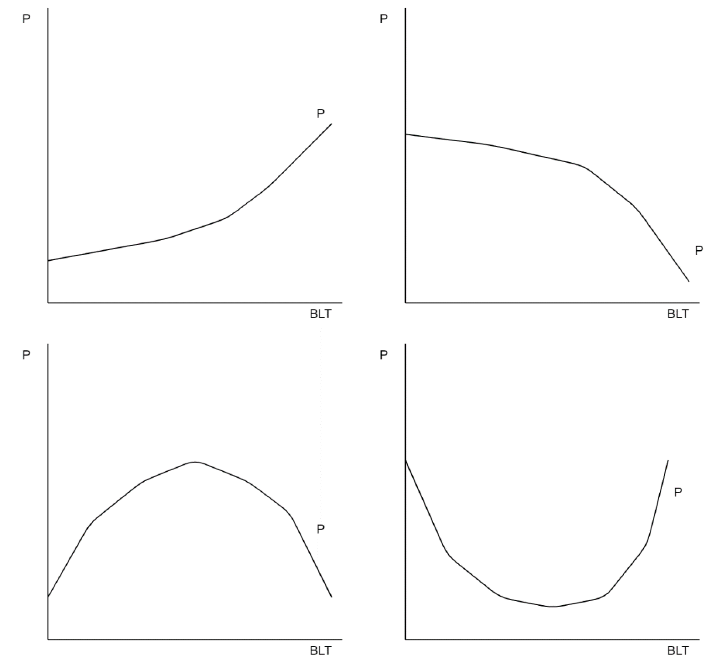
Figure 4. Booking lead time and price changing.